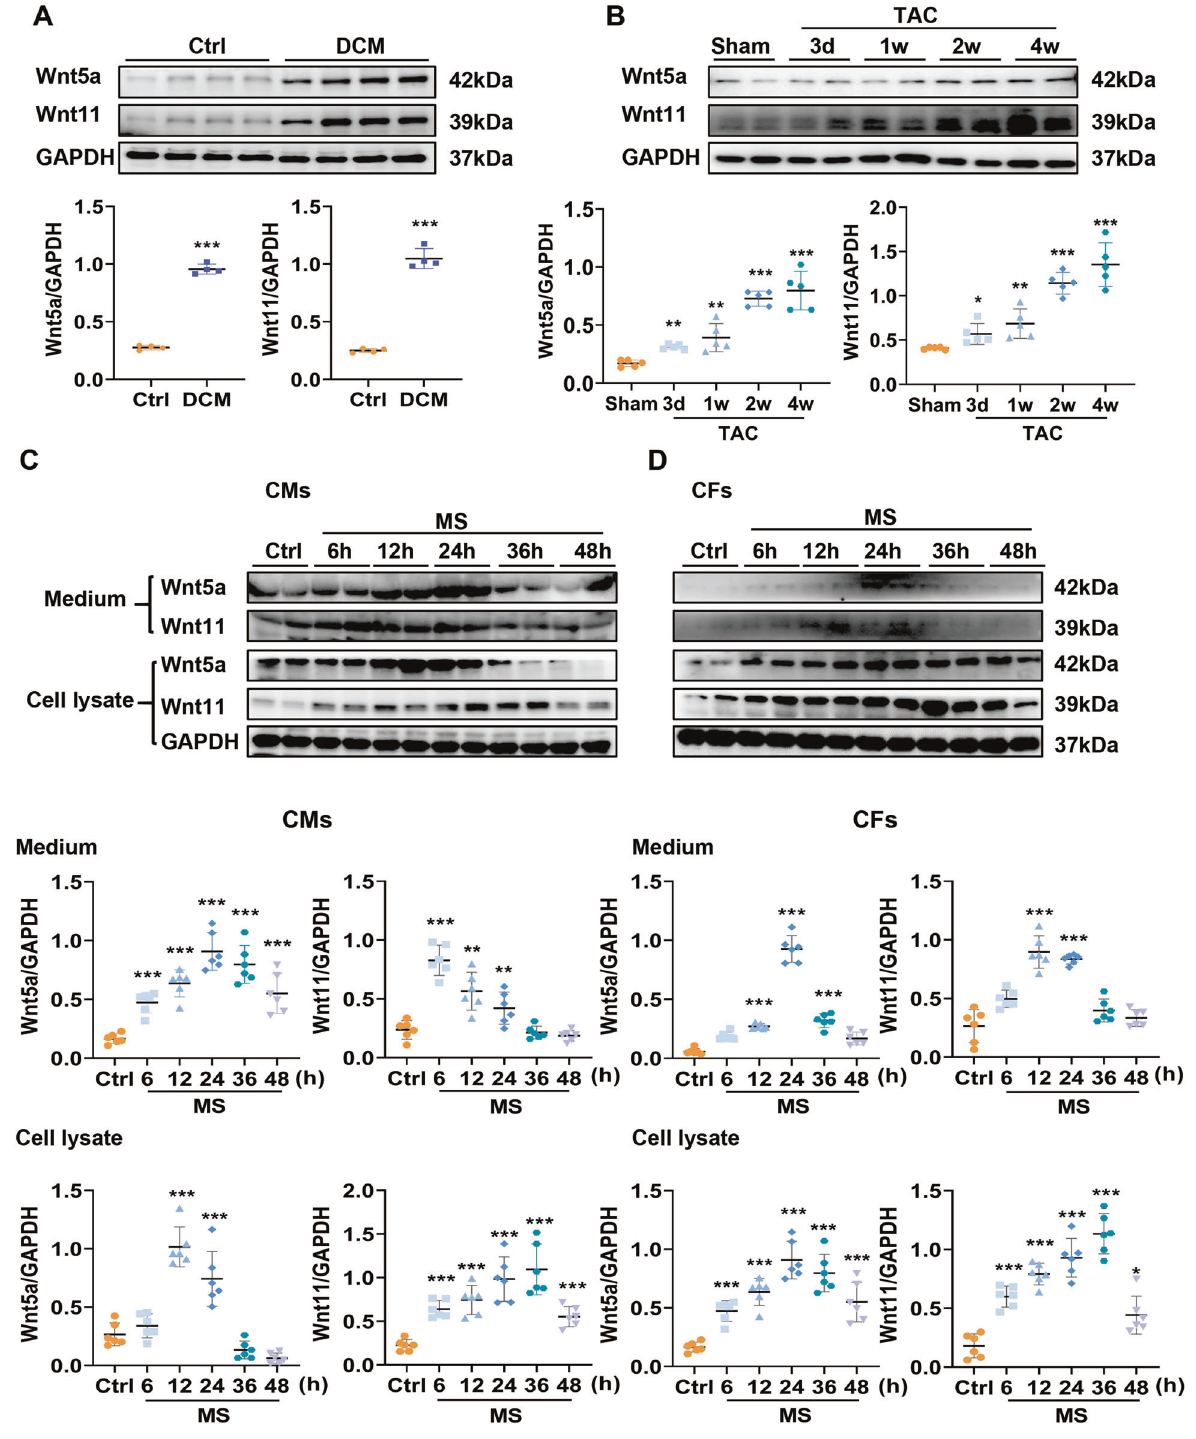
Fig. 2 Pressure overload induces the increased expression and secretion of Wnt5a and Wnt11 from cardiomyocytes and cardiac fi broblasts. A The expressions of Wnt5a and Wnt11 were analyzed by western blot in the heart tissues of patients with dilated cardiomyopathy (DCM) or control (Ctrl) group, n = 4/group. B Western blot analysis of Wnt5a and Wnt11 expressions in heart tissues from TAC mice at different time-points (3 days, 1 week, 2 weeks, 4 weeks), n = 5/group. C , D Western blot analysis of Wnt5a and Wnt11 expression in cardiac myocytes (CMs), fi broblasts (CFs), and their supernatants at different time-points (6, 12, 24, 36, and 48 h) after mechanical stretch (MS), n = 6/group. All data were shown as mean ± SEM; * P < 0.05, ** P < 0.01, *** P < 0.001.